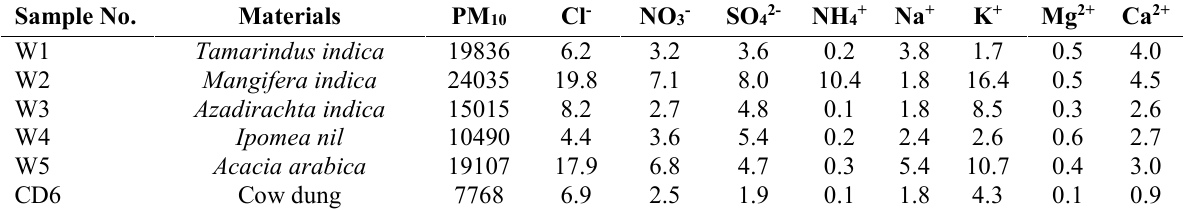
Table 1 Concentration of PM 10 and ions in PM 10 in indoor air, µg m